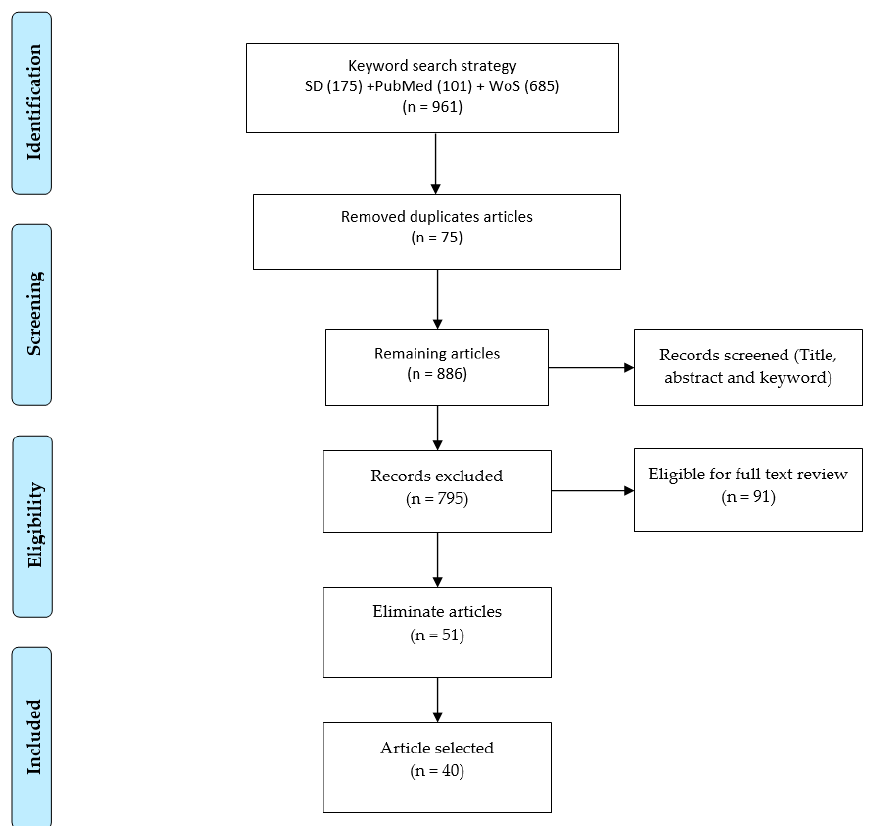
Figure 2. Search and selection strategy for systematic review.